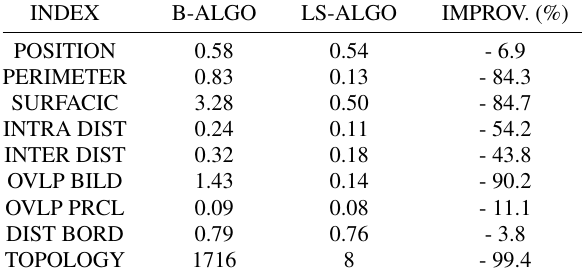
Table 2: Comparison of basic and least squares algorithms.